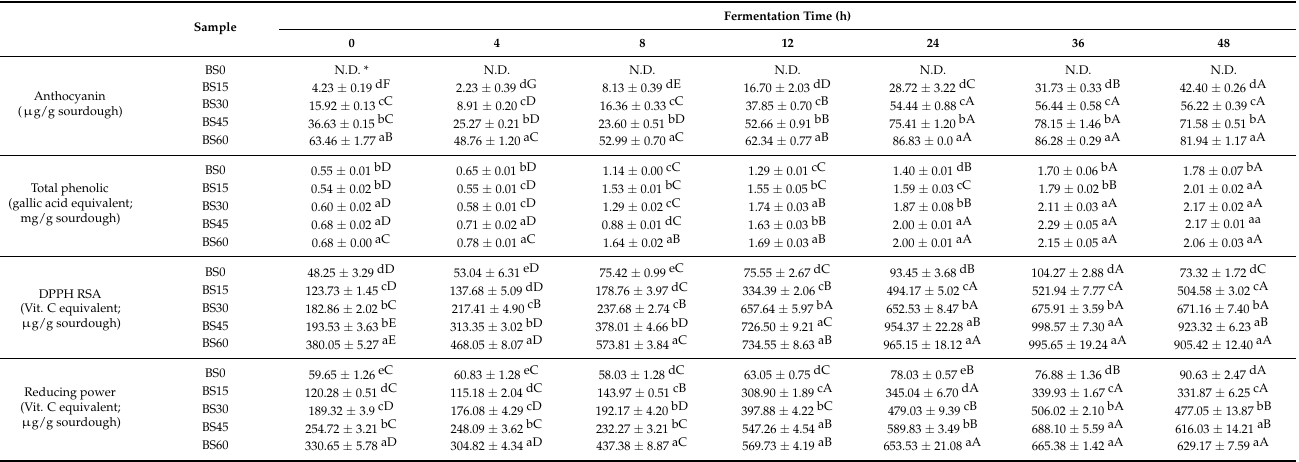
Table 2. Contents of anthocyanins, total phenols, and the antioxidant capacity of black rice sourdough with different proportions of black rice powder fermented for 48